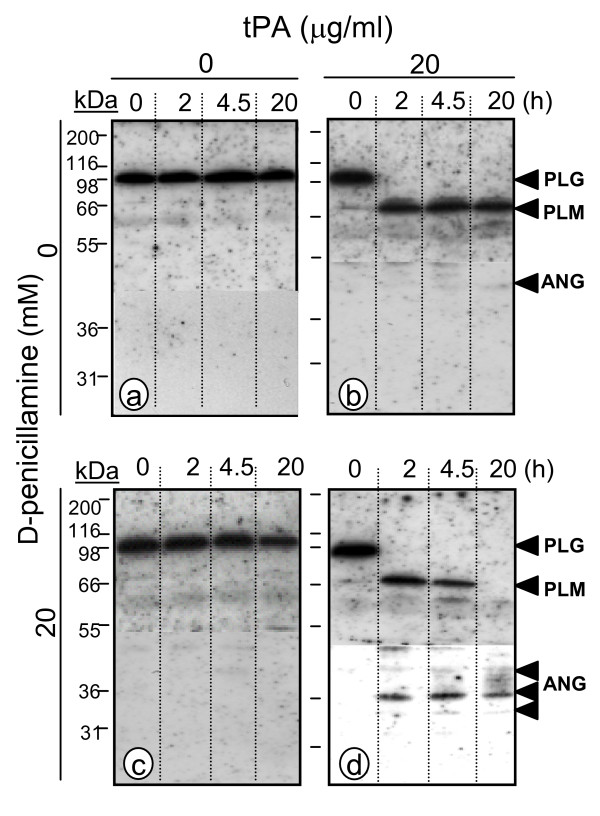
In vitro angiostatin generation by tPA and D-penicillamine. Murine serum was incubated with tPA, D-penicillamine, or a combination of the two. Reaction products were subjected to Western blot analysis employing an anti-mouse plasminogen antibody. In control samples (a) or samples incubated with D-penicillamine (c), no conversion of plasminogen could be demonstrated. Incubation of serum with tPA resulted in the formation of plasmin and a small amount of angiostatin (b), whereas substantial amounts of angiostatin were observed after incubating serum with both tPA and D-penicillamine (d). PLG: plasminogen PLM: plasmine ANG: angiostatin